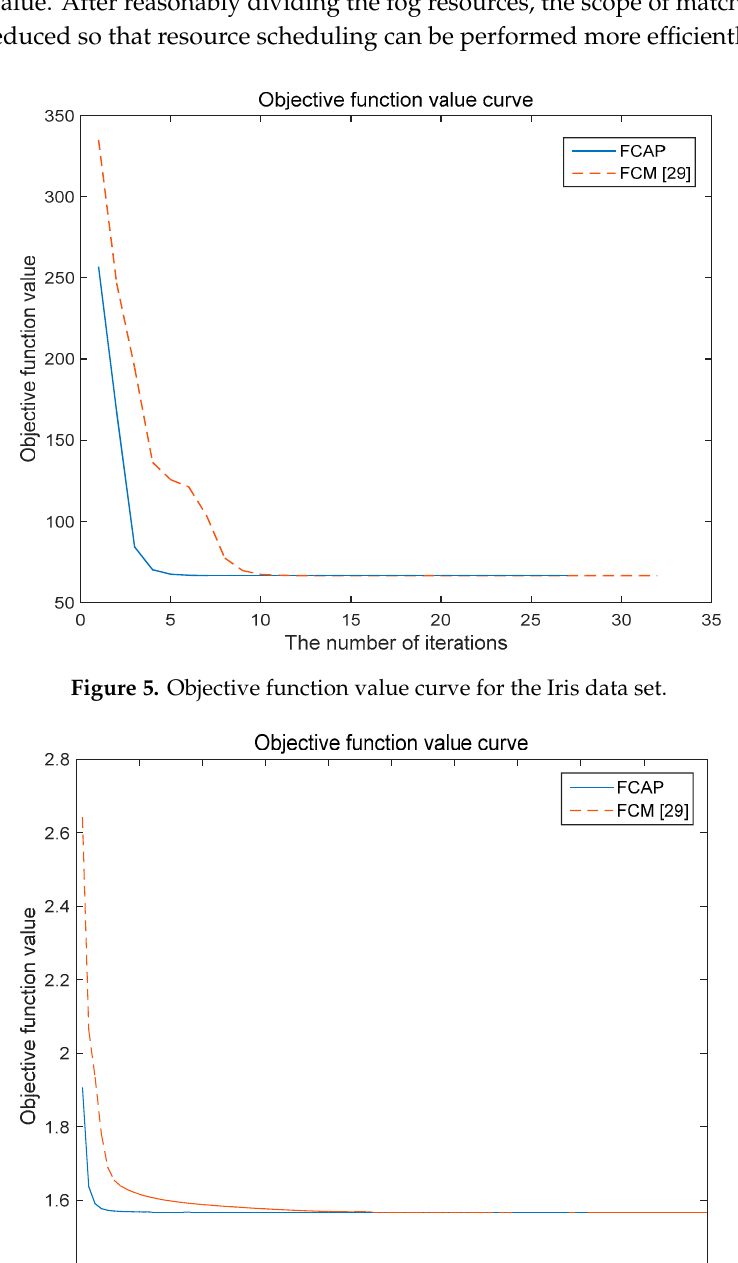
Table 3. Comparison of the clustering accuracy.